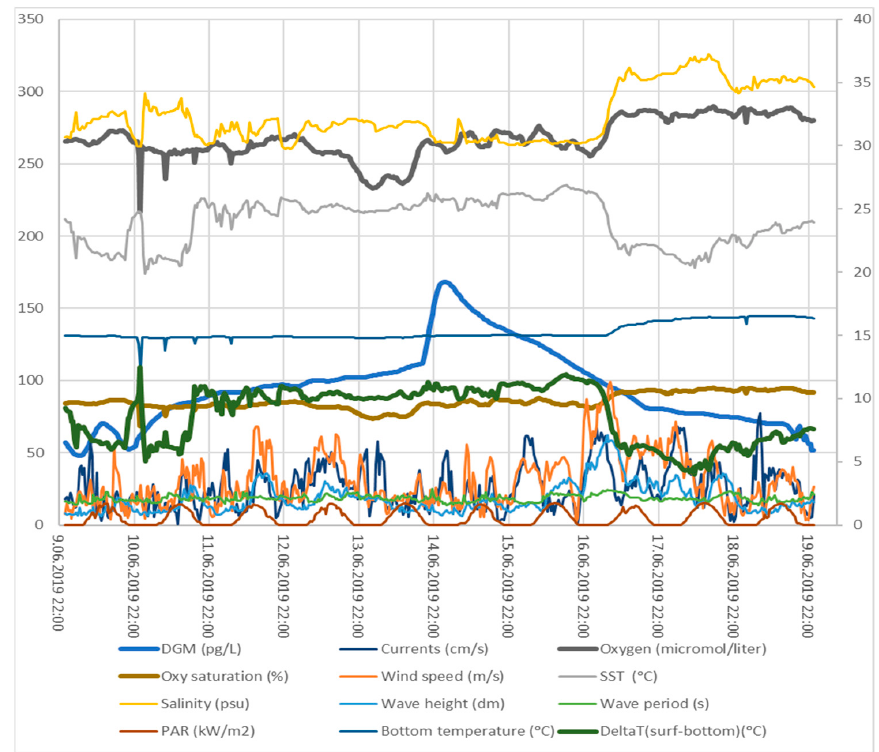
Figure 3. Time series of the observed parameters in the period 10–19 June. The following variables are depicted on the secondary axis: wind and current speed, surface and bottom temperature and the difference between them, wave height and wave period, and PAR and salinity.